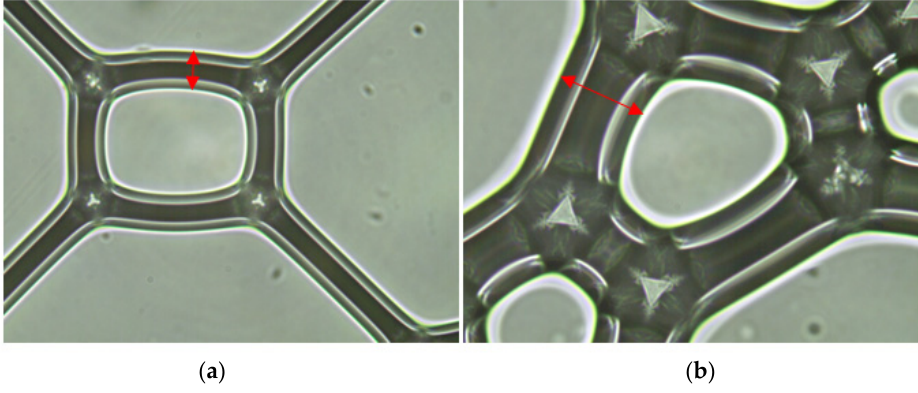
Figure 7. Morphology of foams: ( a ) PS—20 times; ( b ) SRP—20 times.